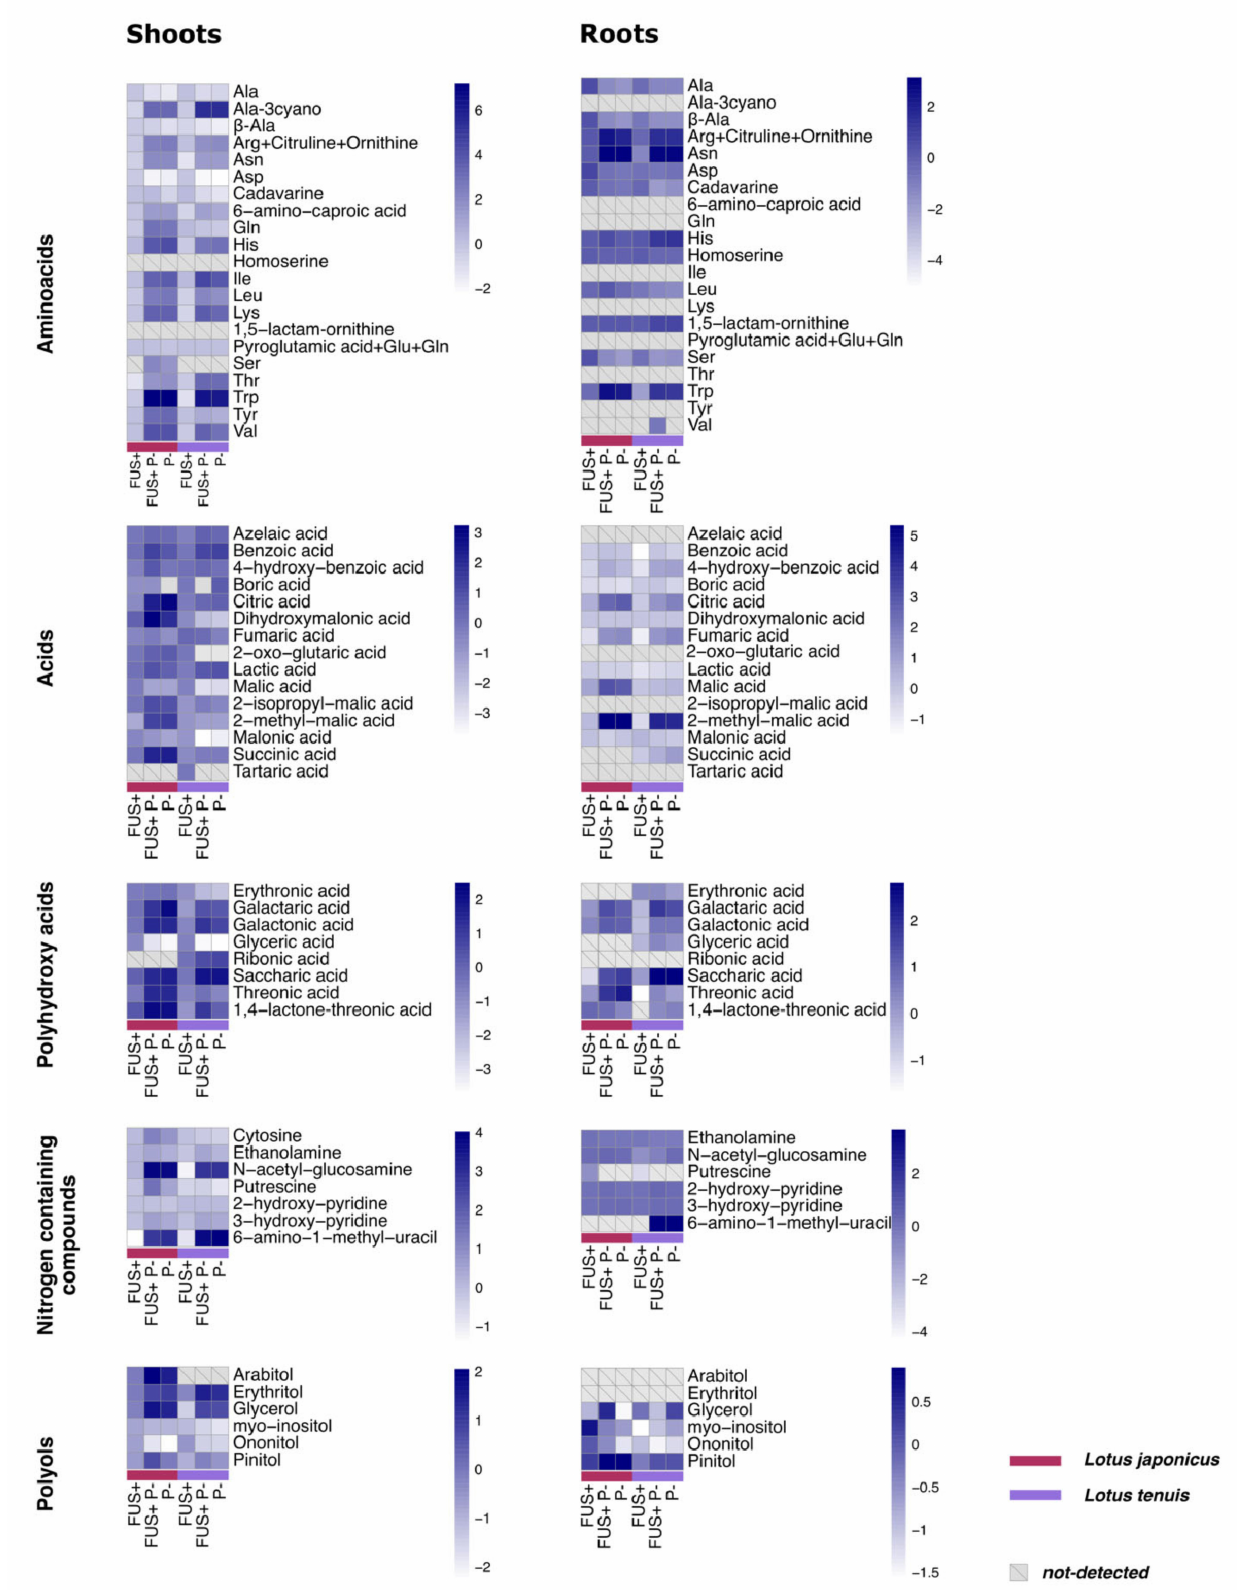
Figure 4. Log 2 -transformed relative concentration of metabolites detected in the shoots and roots of L. japonicus and L. tenuis after 32 days of treatment. FUS+ (inoculated—optimal Pi), P- (noninoculated—Pi starvation) and FUS+P- (inoculated— Pi